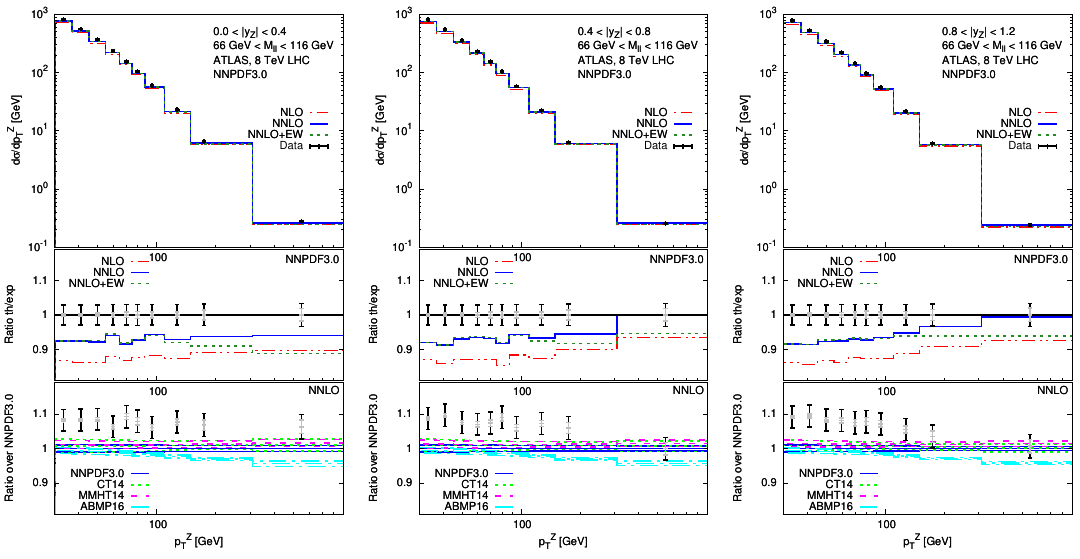
Figure 4 . Same as (cid:12)gure 1 for the ATLAS 8 TeV on-peak data divided into rapidity bins [15]. The three lowest rapidity bins are